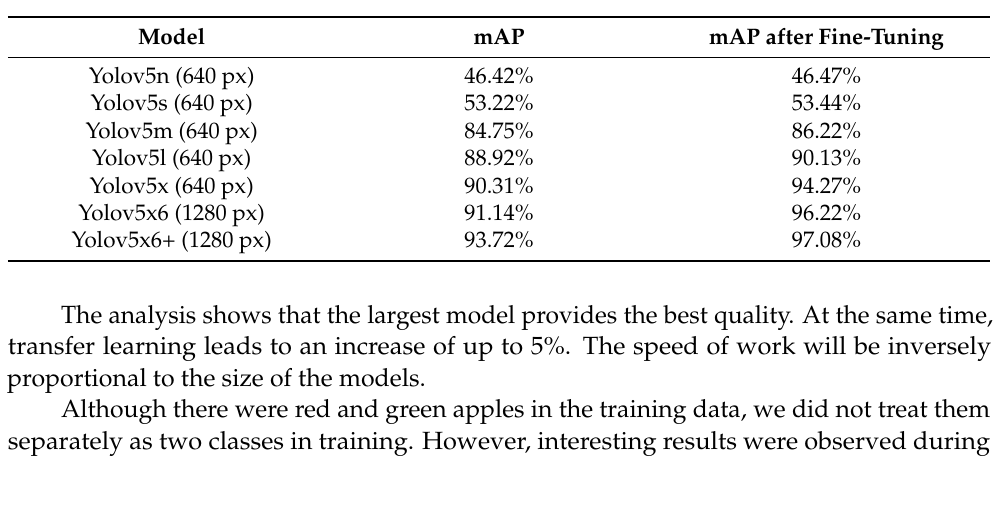
Table 2. Comparative analysis of apple detection